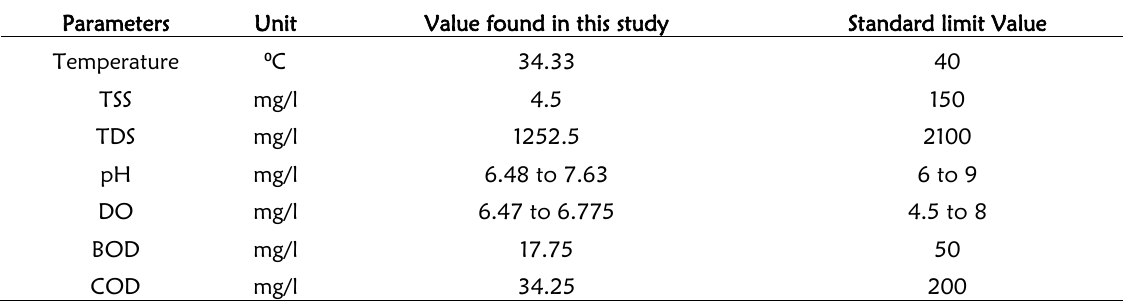
Table 3: Standard for waste from industrial Units (The Environment Conservation Rules, 1997).